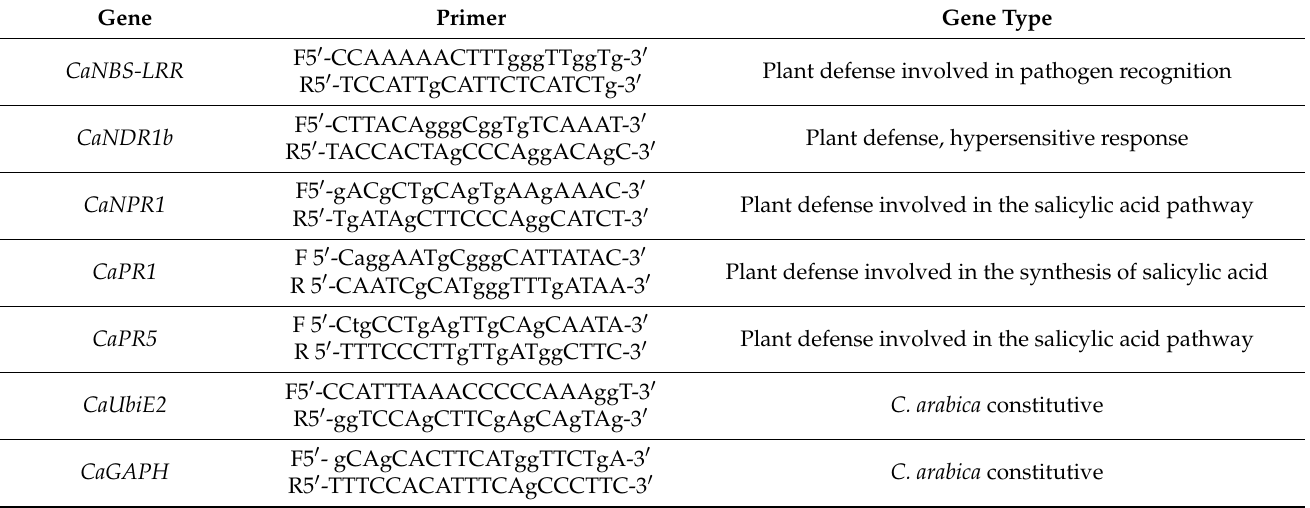
Table 1. Primers designed for genes NBS-LRR, NDR1b, NPR1, PR1, PR5, UbiE2 and CaGAPH , used in the expression analysis for